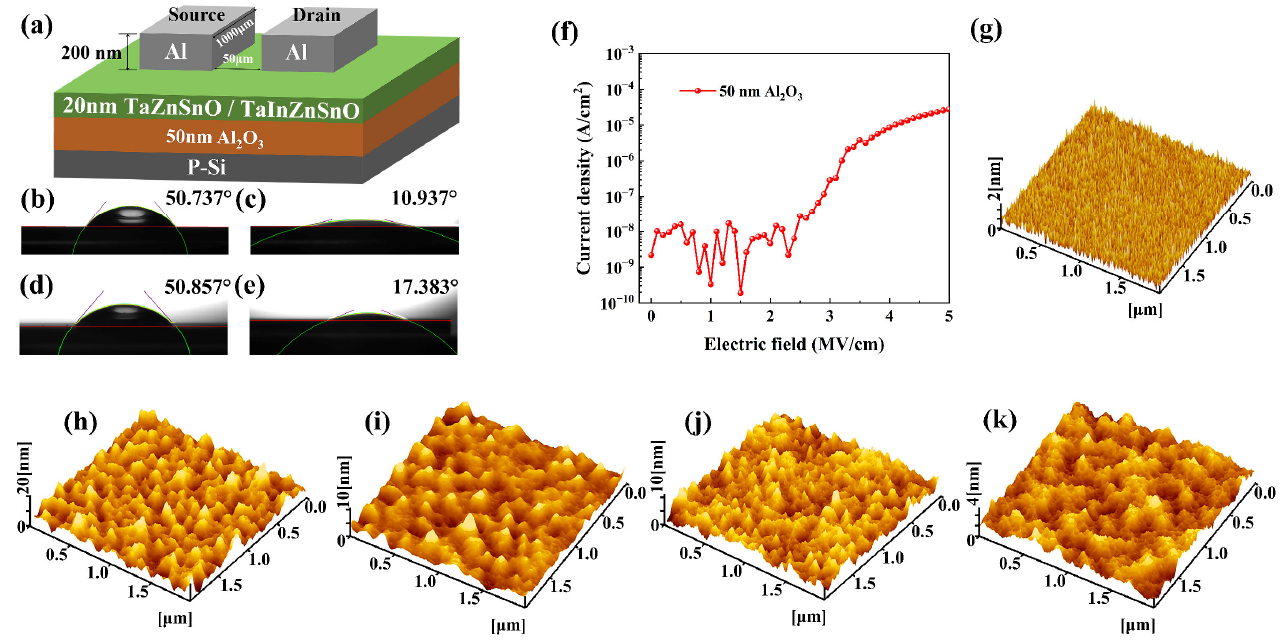
Figure 1. ( a ) The schematic structure of the TaZnSnO/TaInZnSnO TFTs. The water contact angles of Al 2 O 3 films before ( b ) and after ( c ) UV–ozone treatment, and the contact angles of Al 2 O 3 before ( d ) and after ( e ) UV–ozone treatment using 2-methoxyethanol. ( f ) Leakage characteristic curve of Al 2 O 3 film. AFM images of ( g ) 50 nm Al 2 O 3 dielectric layer (2 × 2 µ m 2 ) and TaZnSnO thin films with different Ta 5+ doping contents ( h ) 0, ( i ) 0.5, ( j ) 1, and ( k ) 2